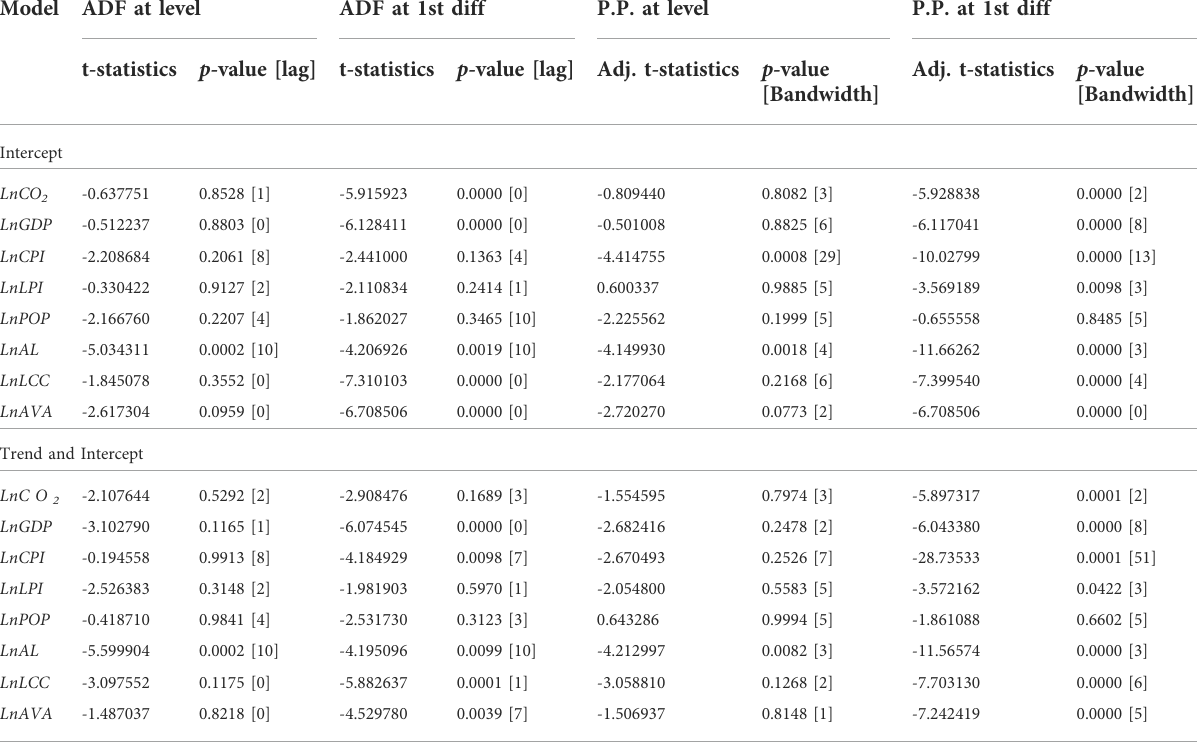
TABLE 4 Results of unit root testing. Model ADF at